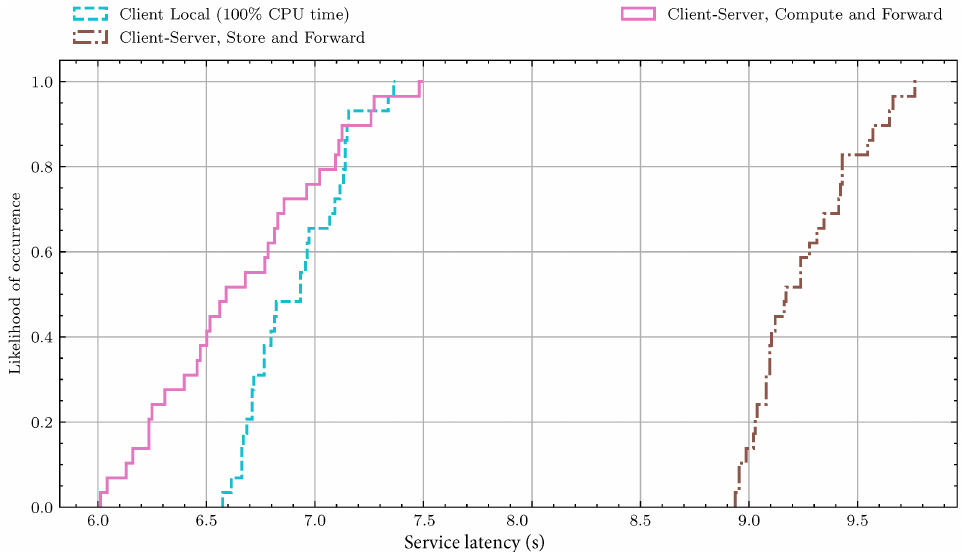
Figure 7. Service latency likelihood for YOLOv2 performed on-device only (with device com- putational resources equal to server-side resources, α = 1), store-and-forward networking with server-side processing only, and compute-and-forward with α = 0.2 client-side processing up to layer 8 of YOLOv2 and remainder processing